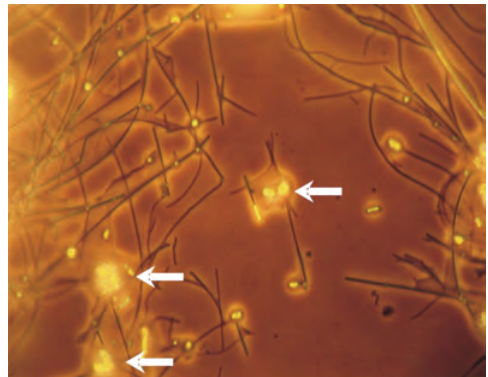
Fig. 4. Thiothrix -like filamentous bacteria (800x) from the whitish mat sampled at C7 site. It is possible to see the presence of sulphur connected to the bacteria.